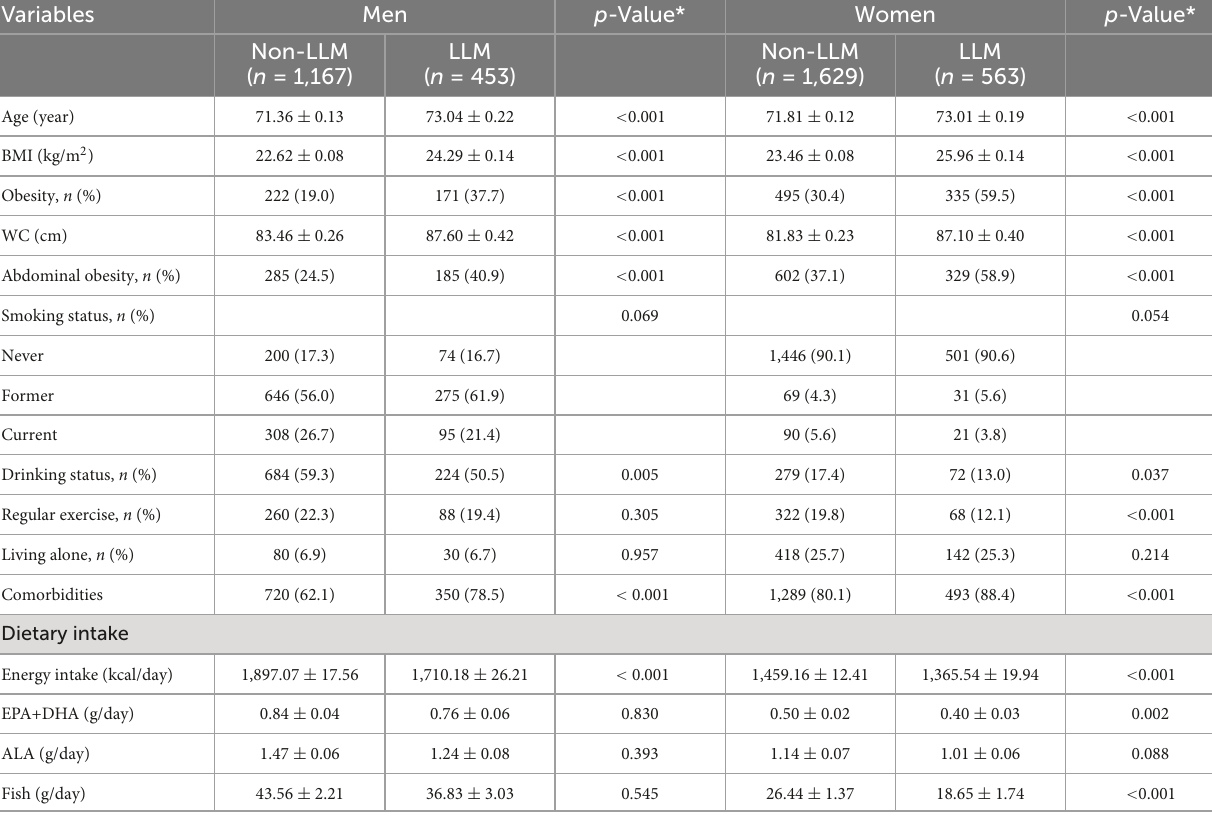
TABLE 1 Baseline characteristics of men and women with and without low lean mass.